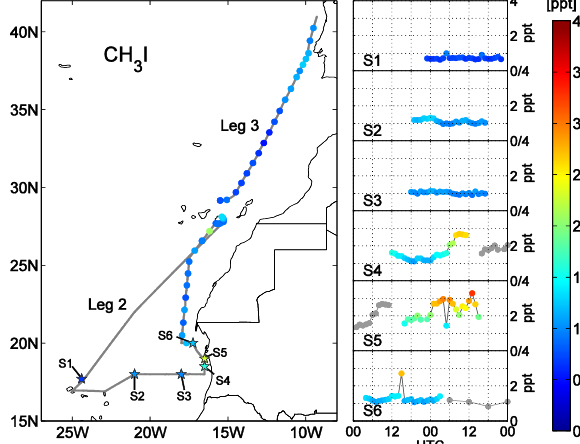
Fig. 8. Dibromomethane mixing ratios [ppt] measured during the DRIVE ship campaign from 31 May to 24 June 2010. Six 24h sta- tions (S1–S6) and measurements during transit are colour-coded ac- cording to the scale on the right side.